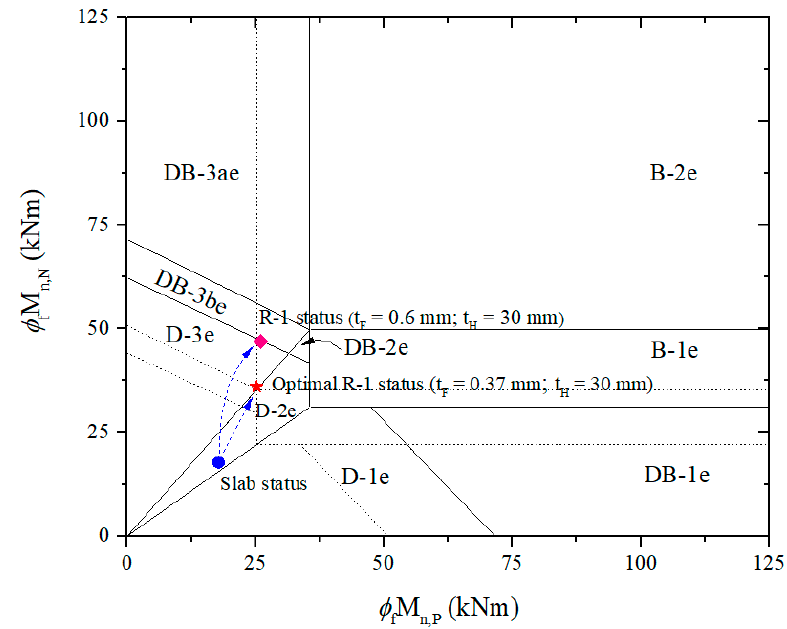
Figure 10. Establish failure limits and predict retrofitted slab status based on moment carrying capacities using the R-1 system.